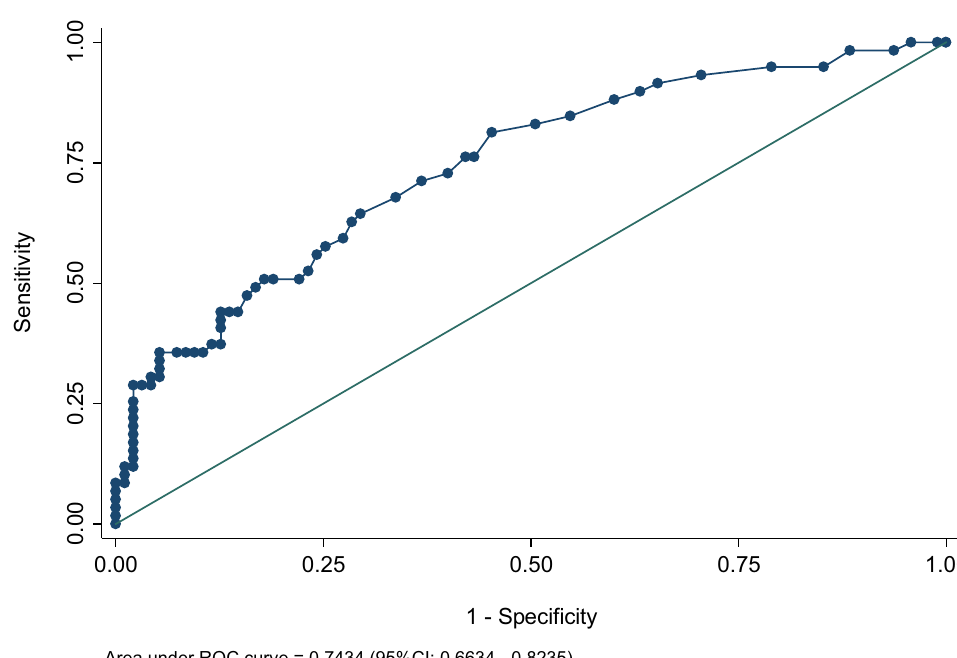
Fig. 2 Receiver operating characteristic (ROC) curves of PSAD in discrimination of prostate cancer